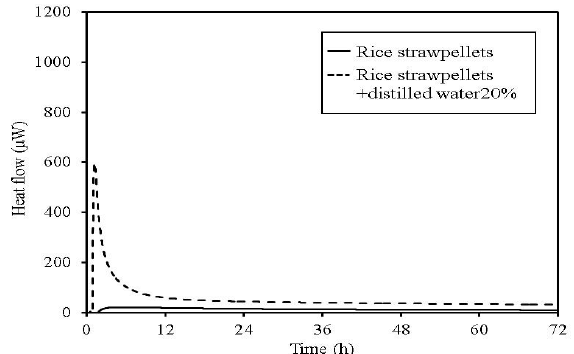
Figure 15. TAM calorimetry curves for rice straw